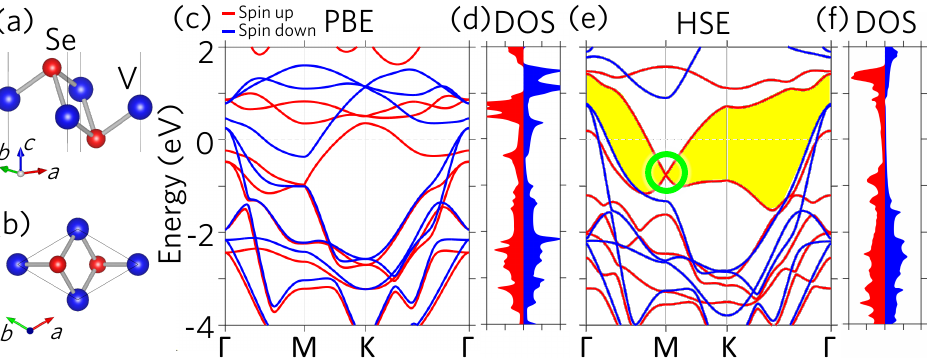
Figure 1. ( a ) Side-view and ( b ) top-view of the monolayer 1 T − VSe 2 lattice structure. ( c ) Band structures given from PBE simulations. The red (blue) lines indicate the spin up (down) bands. ( d ) Density of states (DOS) from PBE. The red (blue) region presents the spin up (down) contributions. ( e ) Band structures and ( f ) DOS obtained using HSE functional. The green circle indicates the Weyl point